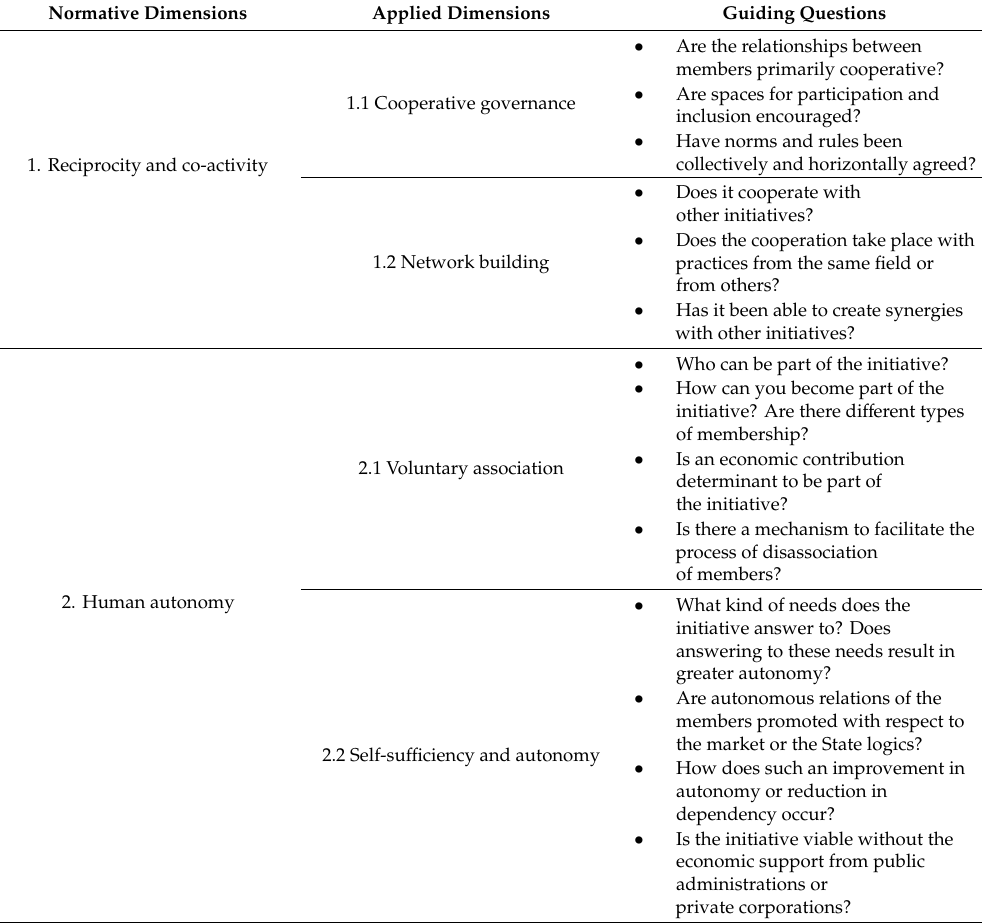
Table 1. Normative and applied dimension of the